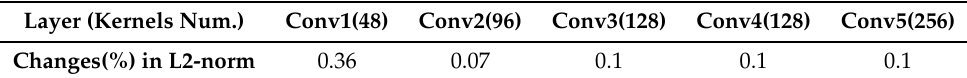
Table 6. Average kernel variation(%) in L2-norm.